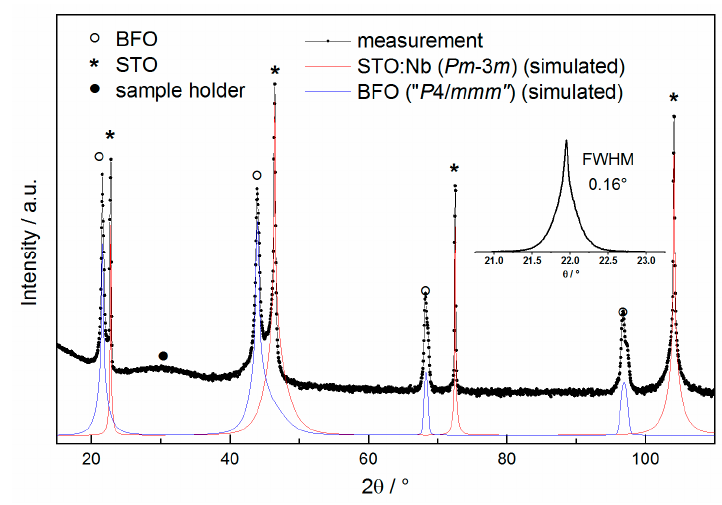
Figure 2. High resolution X-ray diffractogram of an as-deposited BFO film (highest possible symmetry P 4/ mmm due to epitaxial growth in combination with straining), showing film, substrate and sample holder reflections; the inset shows the rocking curve of the (002) reflection. Additionally, simulated intensities from structural data were added for (00l) reflections. Table 2. Out-of-plane lattice parameter after different post-deposition treatments ( ± 0.001